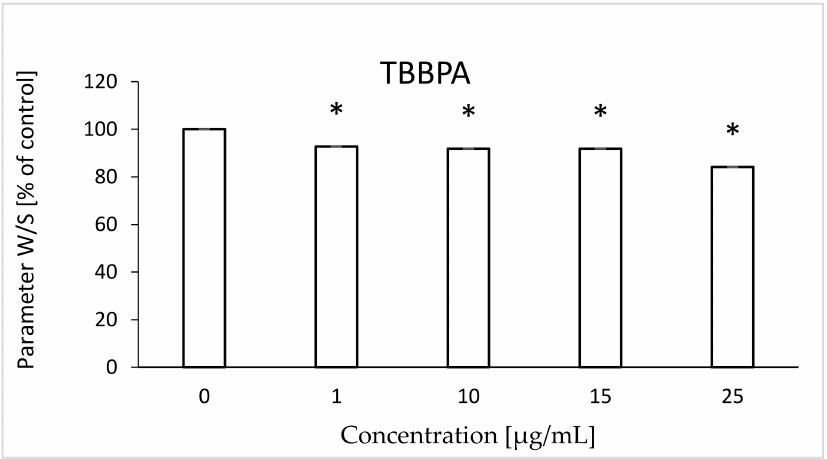
Figure 1. Changes in W/S in human control erythrocytes and the erythrocytes incubated with TBBPA at 1 to 25 µ g/mL for 48 h. (*) Significantly different from control ( p <